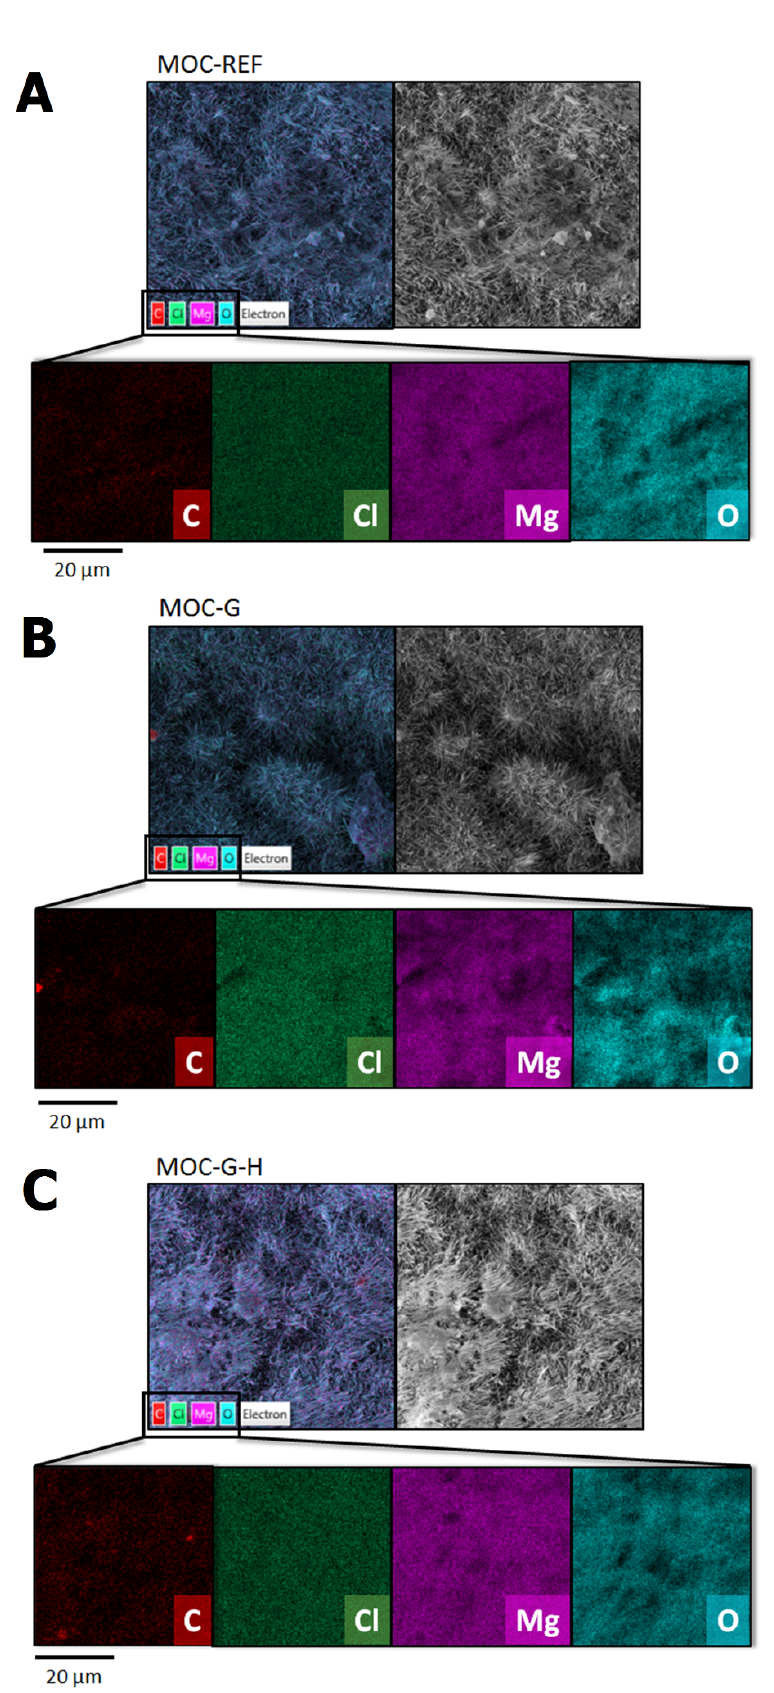
Figure 7. EDS elemental maps of samples: ( A ) MOC-REF, ( B ) MOC-G, and ( C ) MOC-G-H.